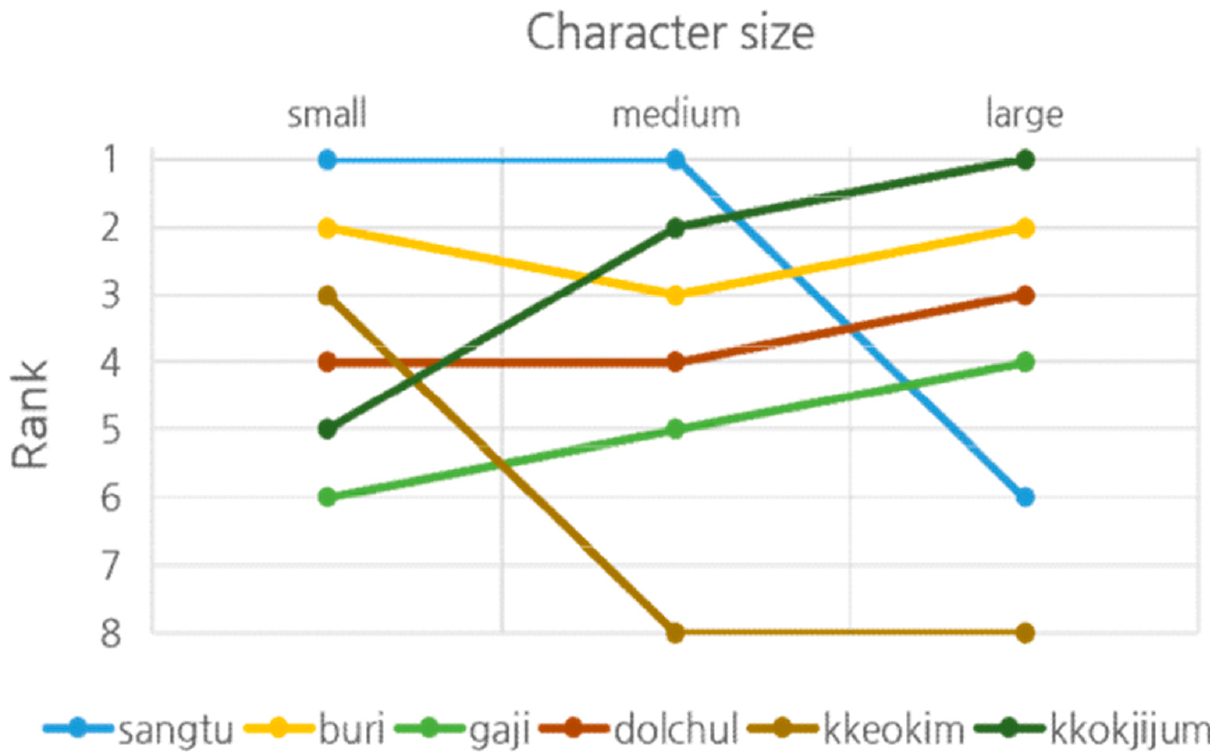
Figure 8. Change the rank of stroke element influences by character size.